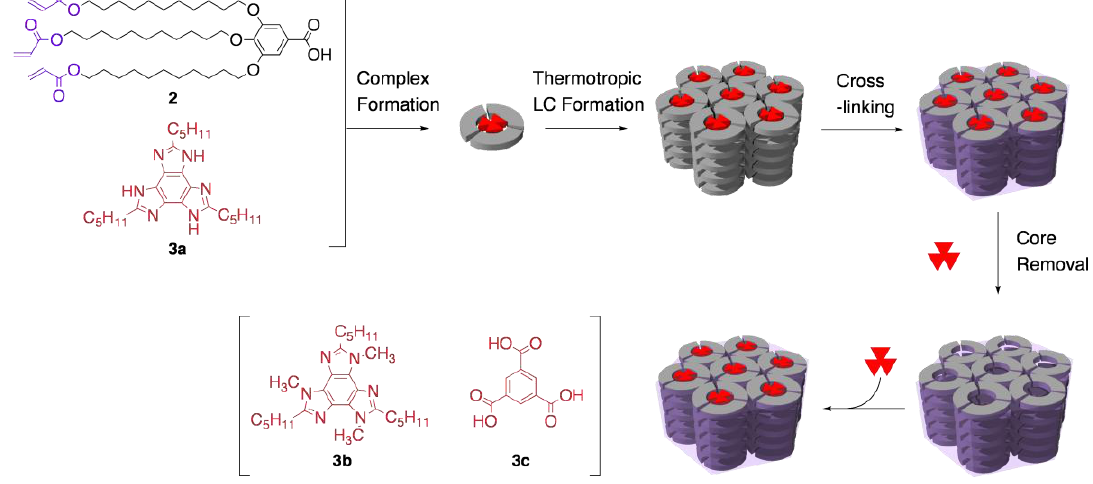
Figure 3. Solid-state host based on the cross-linking of a thermotropic LC: Preparation and functionality selective incorporation of